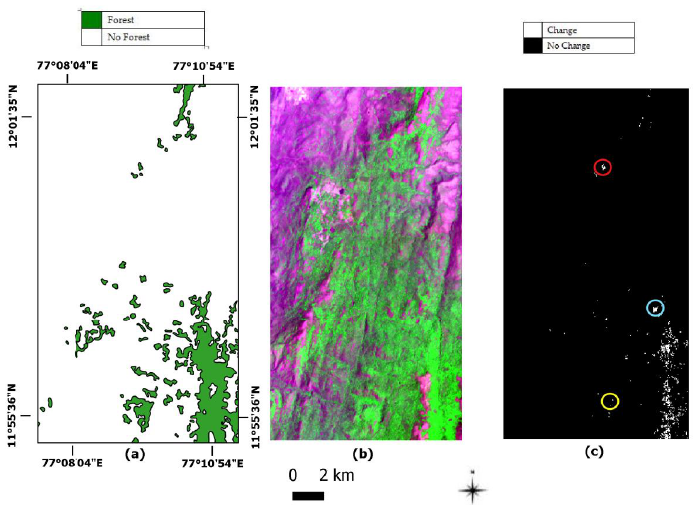
Figure 11 Figure 11. Experiment 2.a—CCA_HR, Indian site. Close-ups of evergreen forest layer: ( a ) vegetation map (T 1 = 1998); ( b ) Landsat 8 OLI image, 20 March 2016, RGB: Red–Nir–Blue (T 2 ); and ( c ) change map obtained by CCA, TH = µ + 1 σ